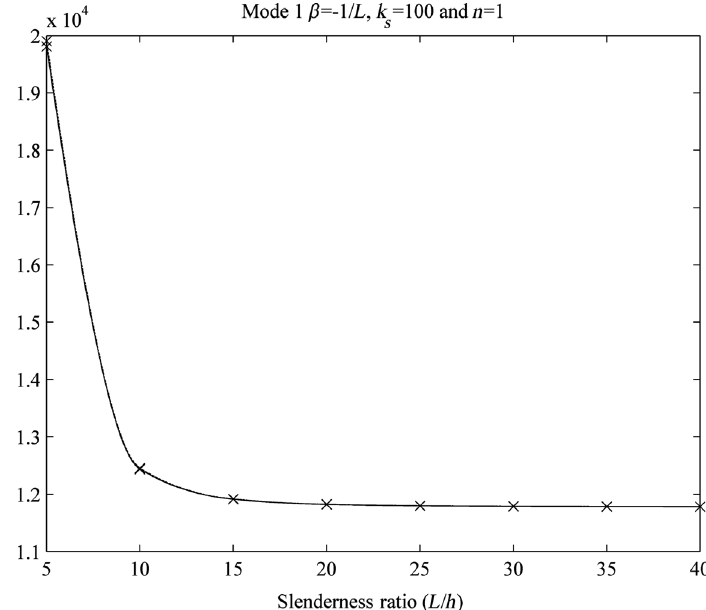
on the mode shape for cantilever FG beam. It is found that the maximum amplitude occurs at the right end of the narrowing cantilever beam. It is also seen from Figure 9 that the amplitude of the beam decreases with expanding width at the right end of the